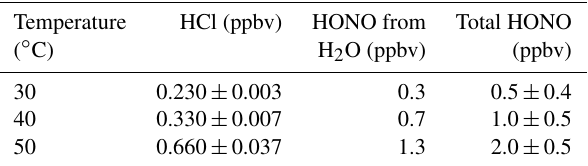
Table 3. Average mixing ratios of HCl input (PD-6a), and HONO emitted from reaction with water vapor and with both reagents as a function of temperature. Uncertainty denotes 1 σ standard deviation from the mean of measured values.